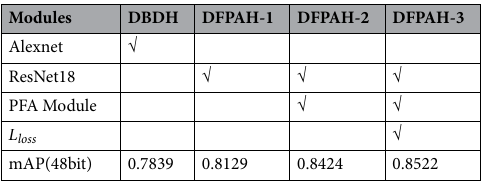
Table 5. Ablation experiments.